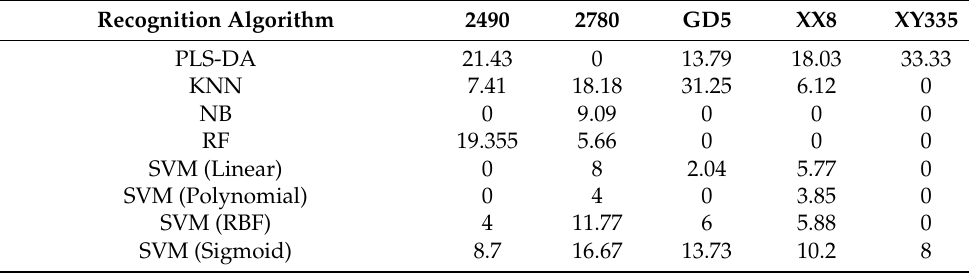
Table 6. The misclassification